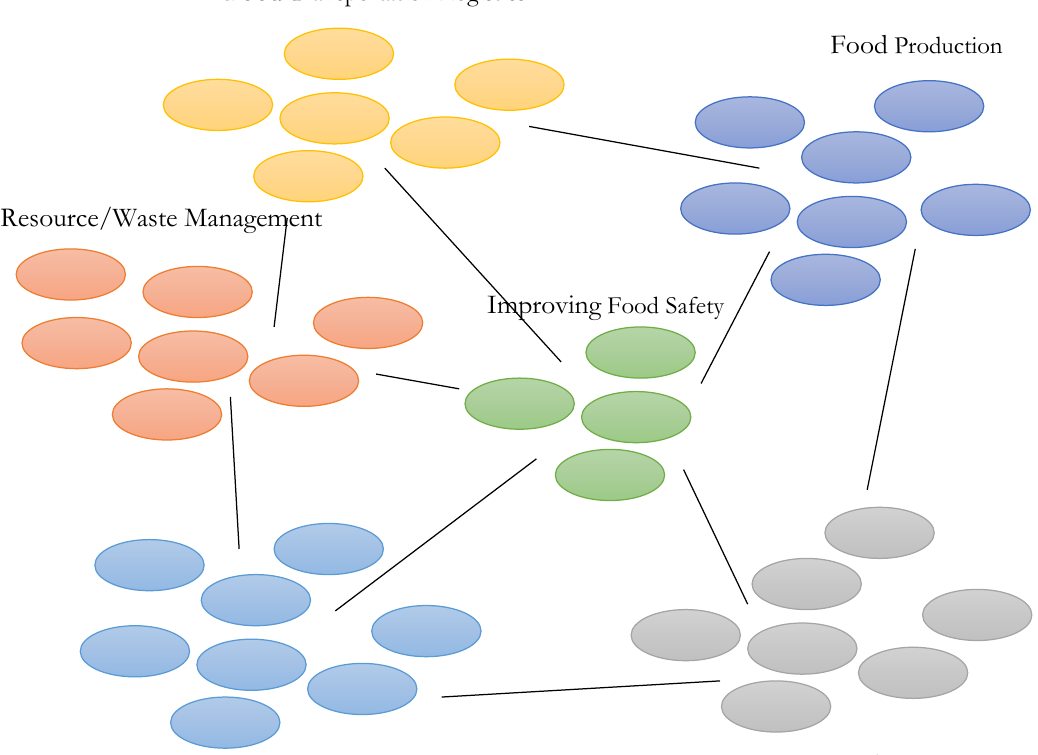
Fig. 5. Clustering of IoT applications in the food supply chain.